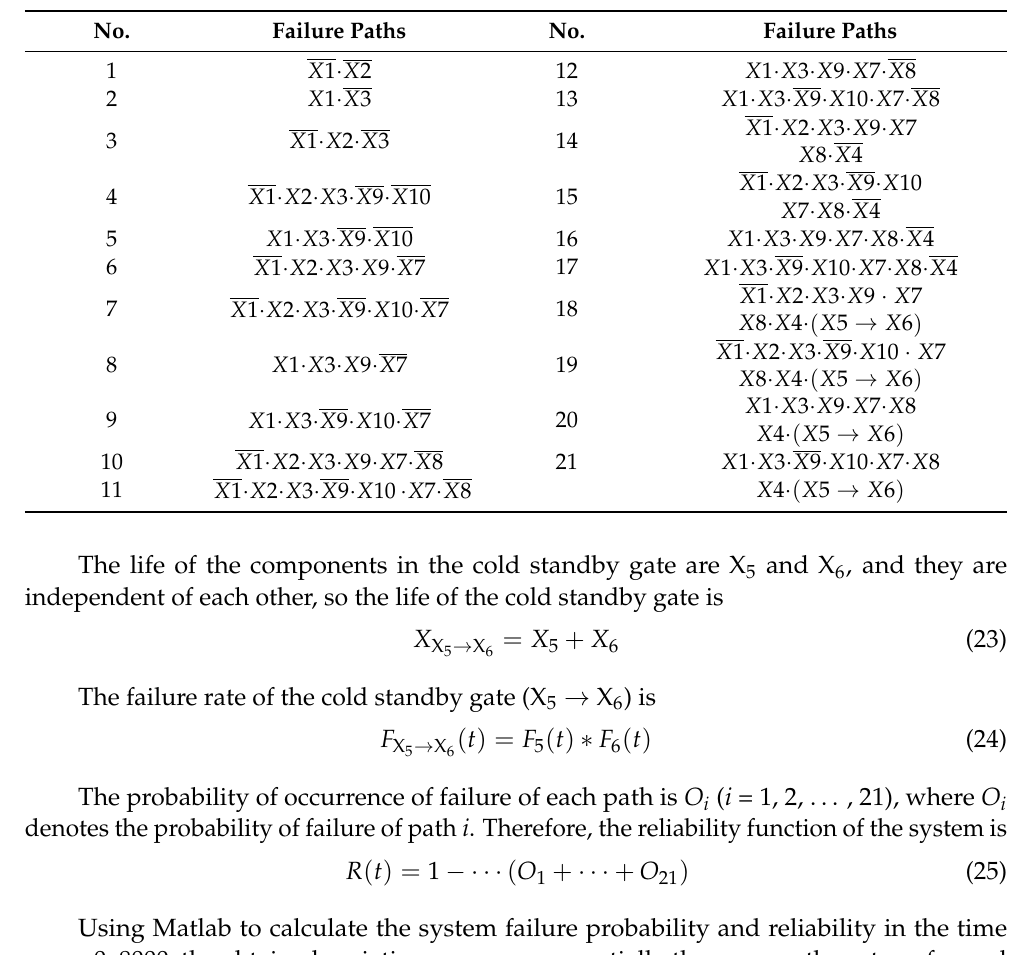
Table 3. Failure paths of automotive airbag systems.